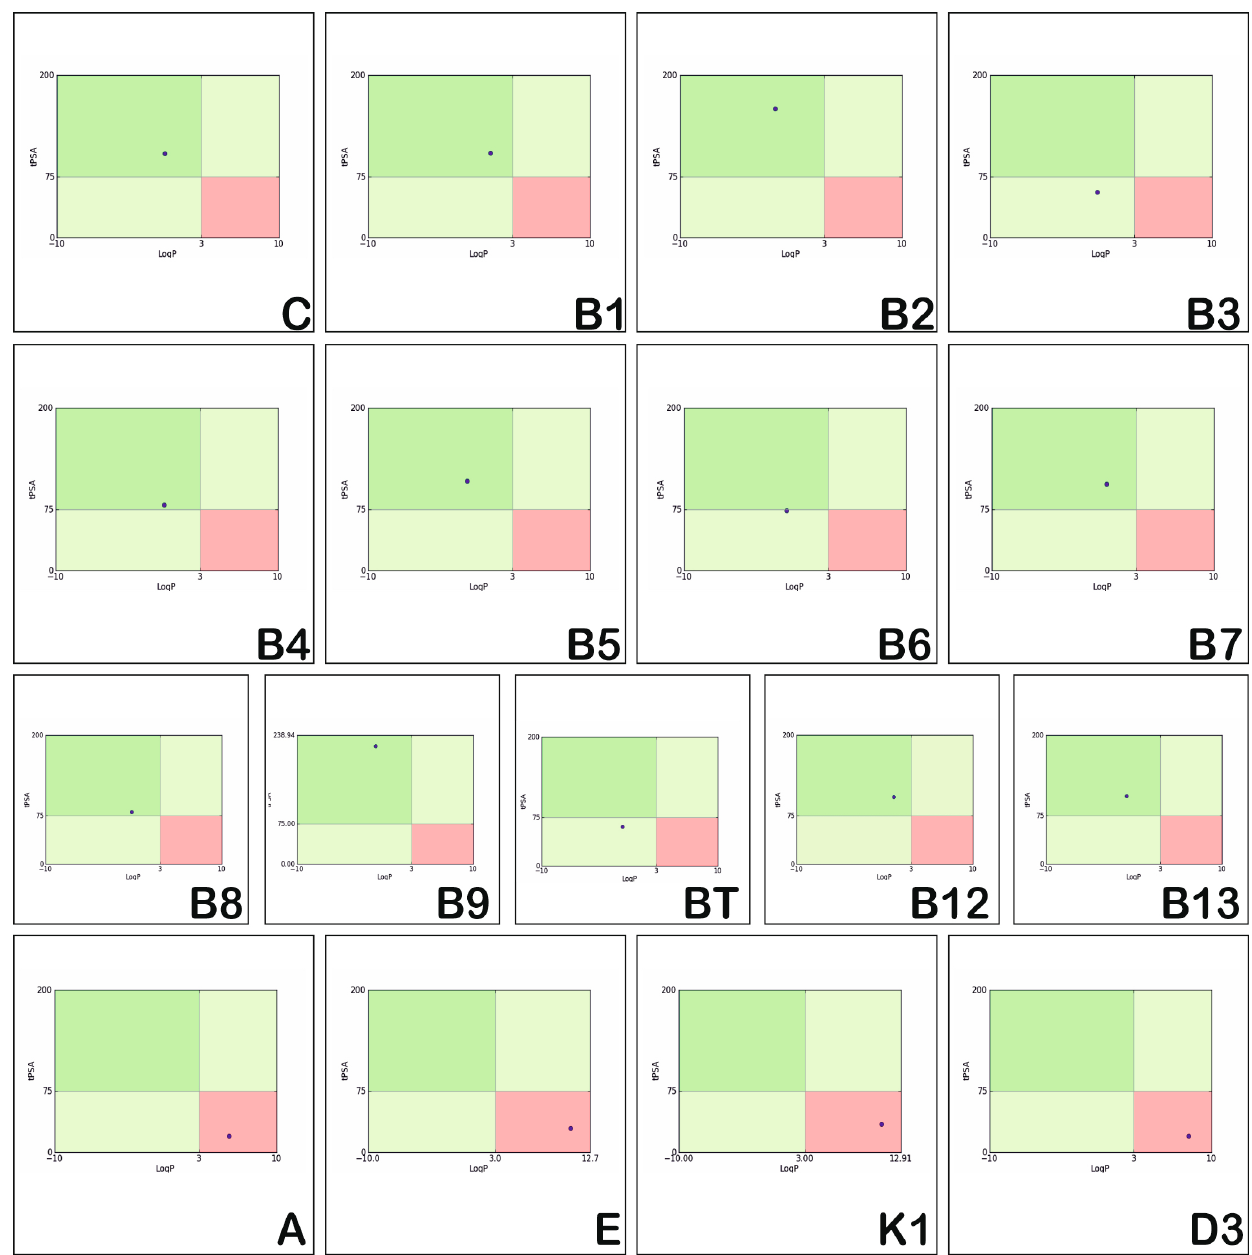
Figure 6. Toxicity assessment of the hydrosoluble and liposoluble vitamins. Figure 6 reveals that the physico-chemical properties of the hydrosoluble vitamins (blue dots) correspond to dark green regions (the left-upper corner region) and they are either not toxic (C, B1, B2, B4, B5, B7, B8, B9, B12, and B13) or they reflect low toxicity (B3,